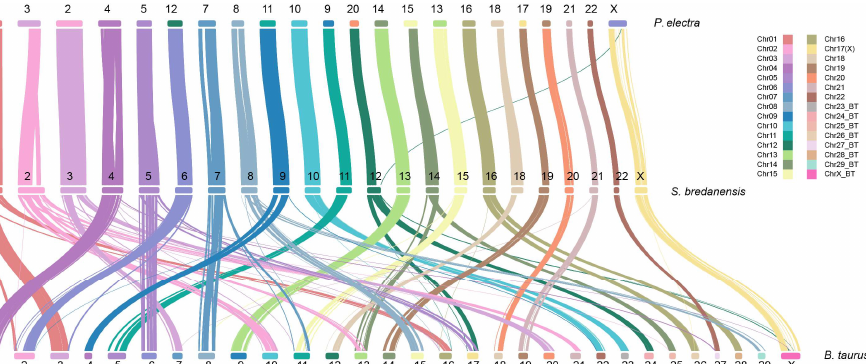
Figure 2. Chromosome-level synteny analysis between S. bredanensis and P. electra and B. taurus . Approximately 36.58% of the assembled S. bredanensis genome was annotated as transposable elements (TEs), including long interspersed nuclear elements (LINEs; 33.28%), short interspersed nuclear elements (SINEs; 0.41%), Long Terminal